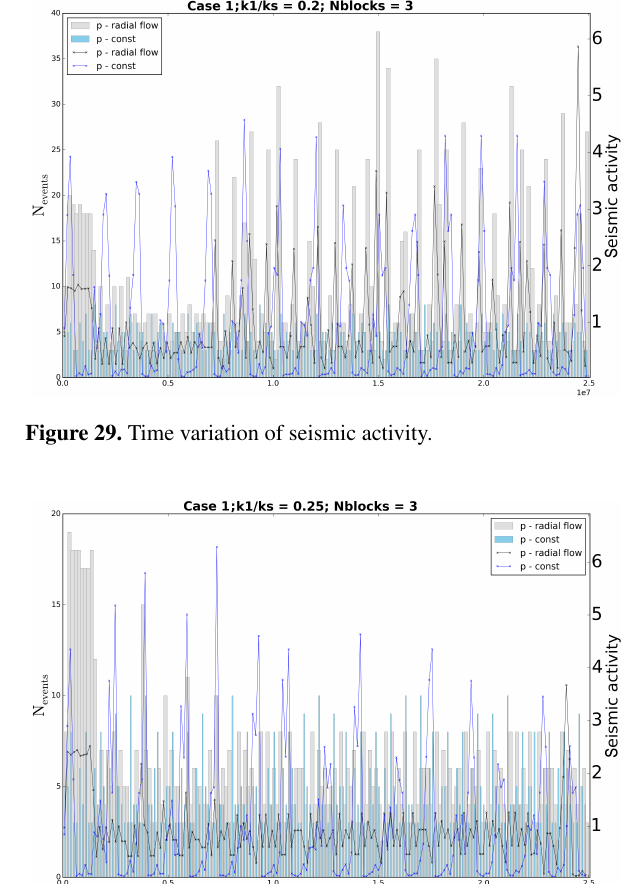
comes more evident with a decrease in parameter A .